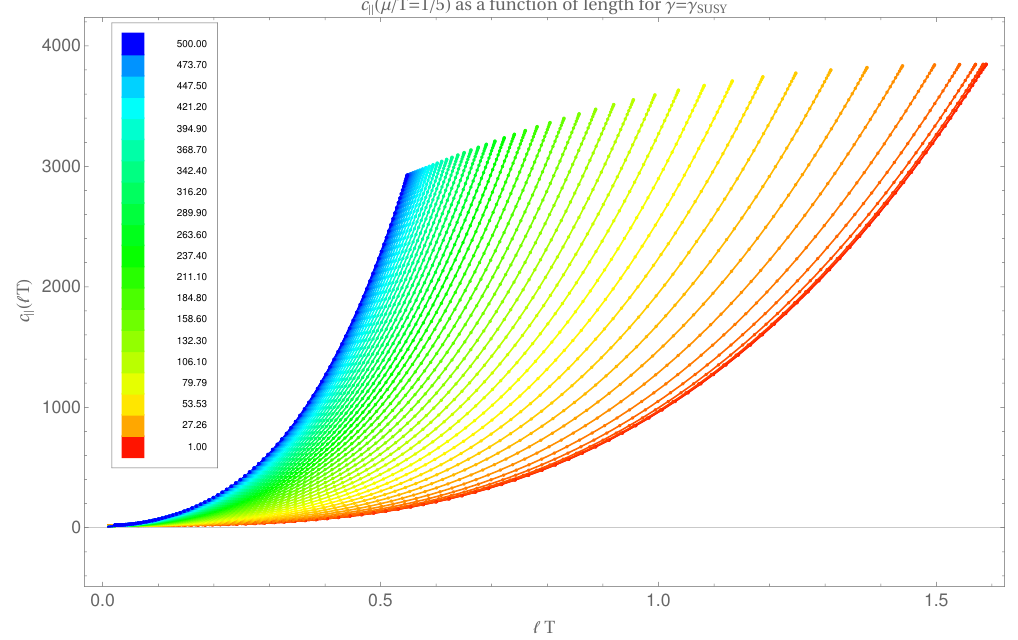
Figure 20 . We display the c -function at γ = γ SUSY as dots along with lines indicating a cubic fit || of the numerical data c = P 3 b i ( ‘T ) i . The c-function is displayed as a function of dimensionless || i =0 length scale ‘T at fixed µ/T = 1 / 5 for B/T 2 varying from B/T 2 = 1 . 00 to B/T 2 = 500 . 00 . The horizontal axis, ‘ T , can be understood as RG - or energy scale of the